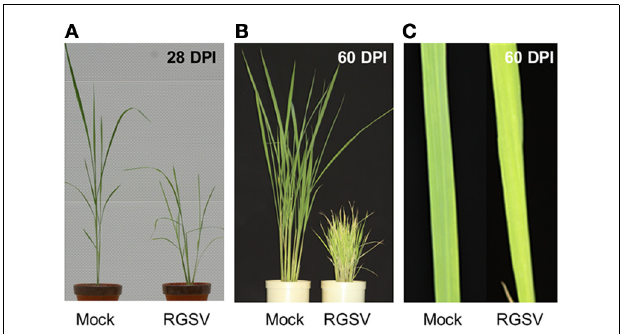
FIGURE 1 | Symptoms in rice caused by RGSV infection. (A) Rice plants at 28 days and (B) 60 days after RSGV inoculation and mock inoculation. (C) Leaf yellowing of RGSV-infected plants at 60 days after